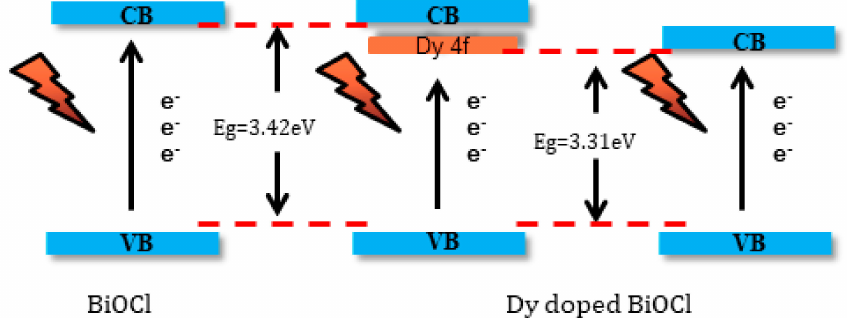
Figure 8. The schematic of reduction in the band gap of